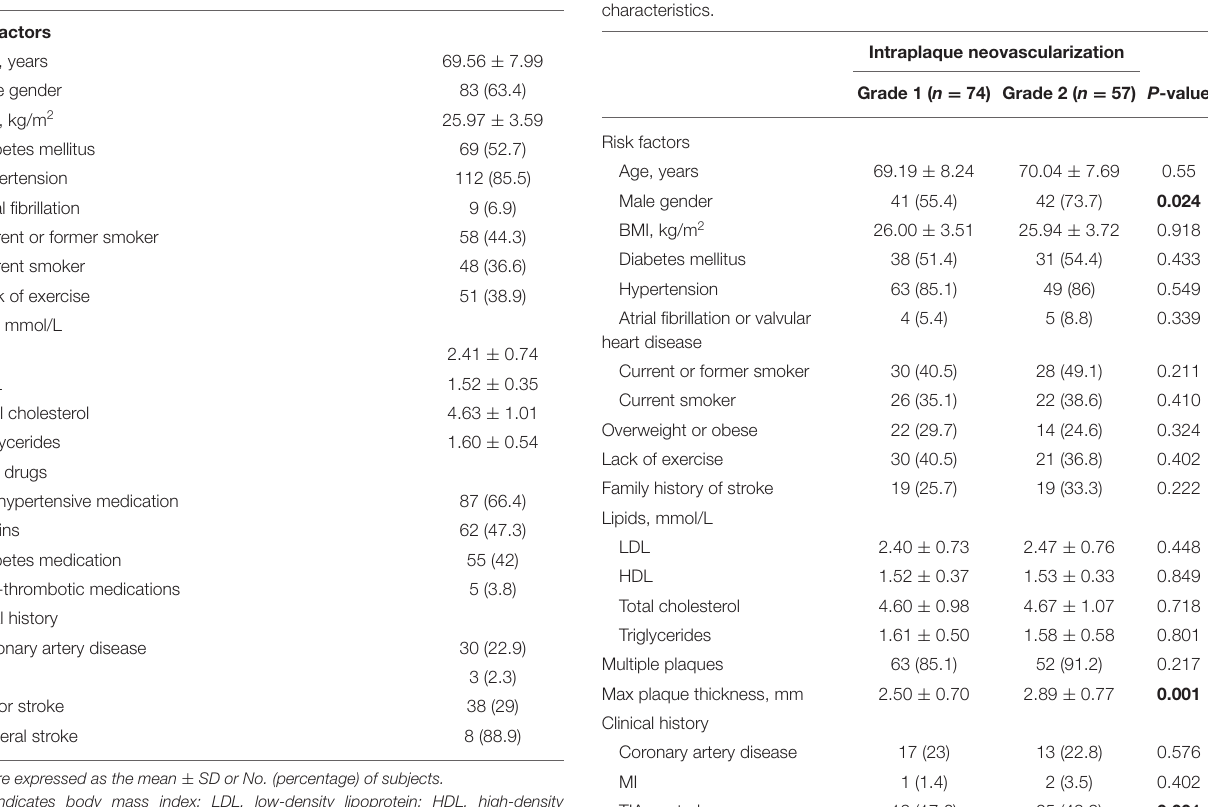
TABLE 1 | Baseline characteristics of all consecutive patients ( n = 131).